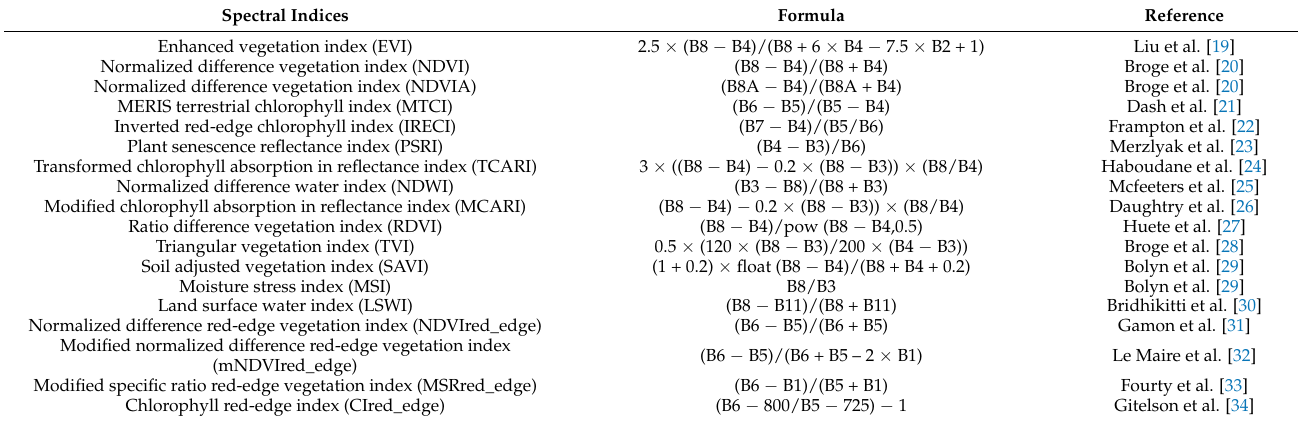
Table 5. Calculation formulas for the spectral index feature